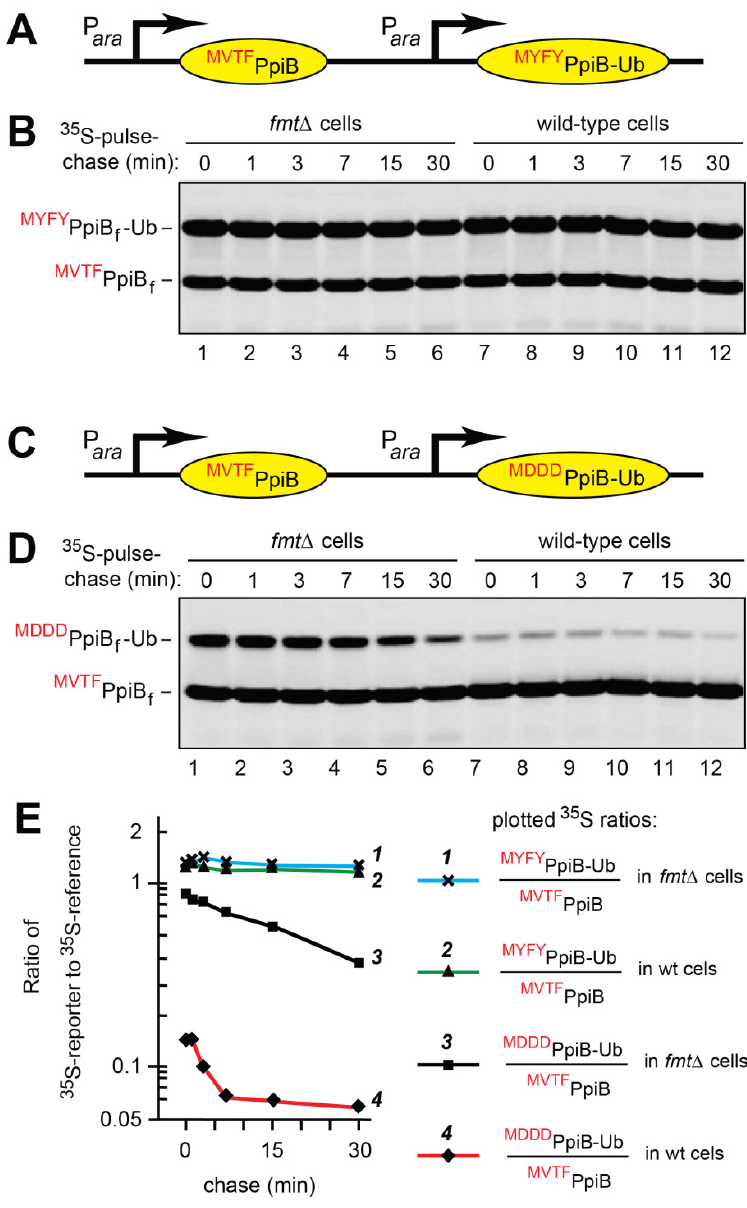
FIGURE 4: Formylation-dependent selective destabilization of PpiB-based reporter